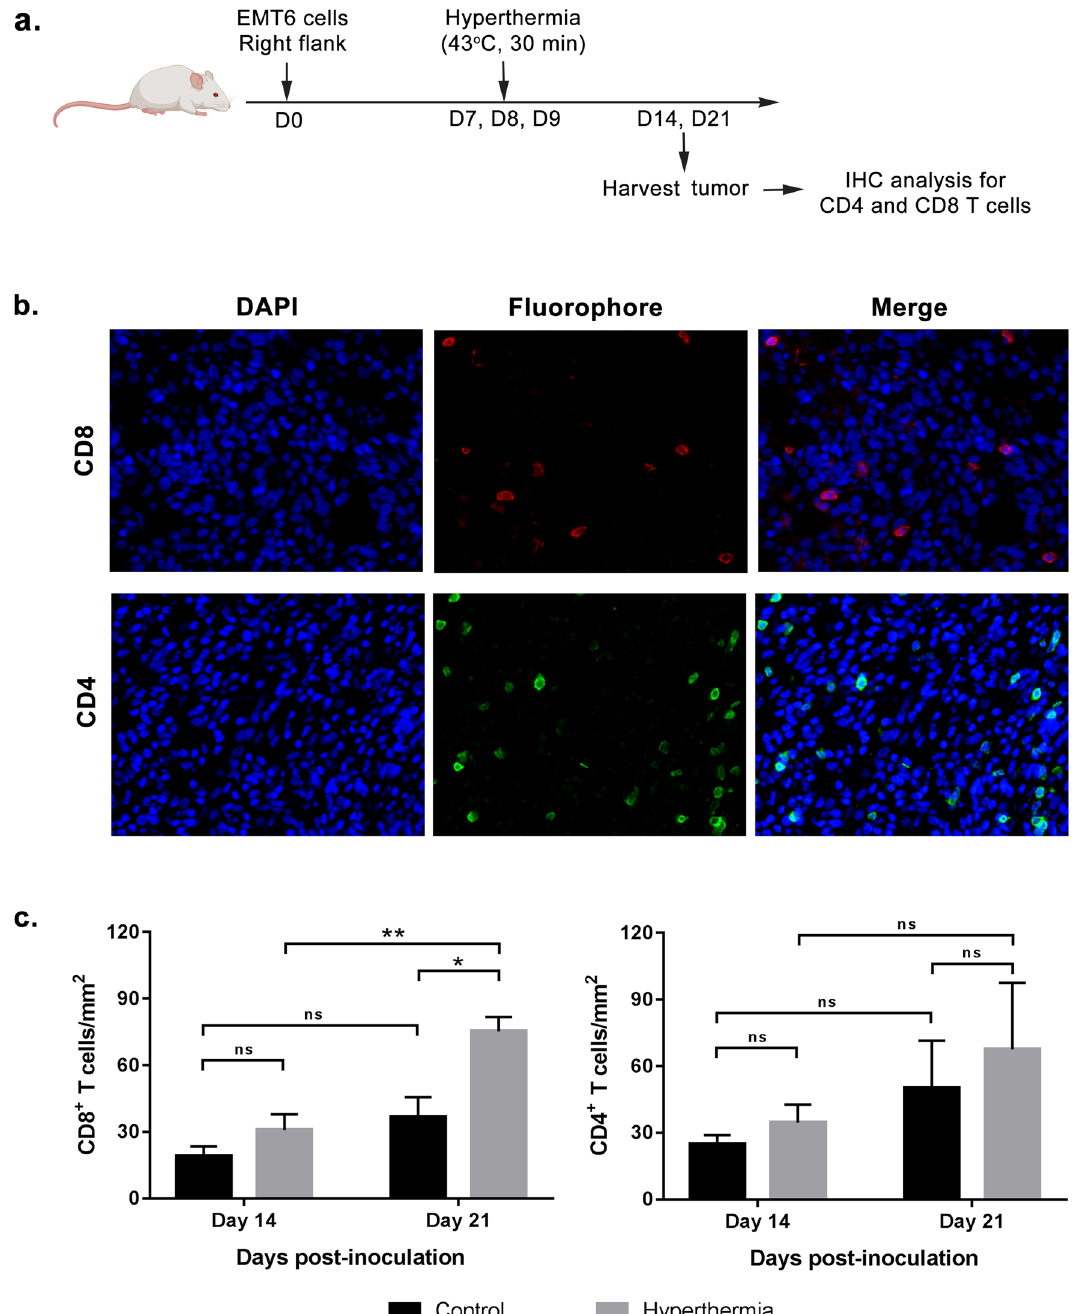
Figure 5. CD8 and CD4 T cells infiltrated in tumor increases over time. Mice were sacrificed at two time points after the treatment; day 14 and day 21 post-inoculation. Tumor were harvested and paraffin-fixed for staining with anti-CD4 and ant-CD8 antibody. ( a ) Schematic time course to measure the number of tumor–infiltrated CD4 + and CD8 + cells by immunohistochemical analysis. ( b ) Representative fluorescence images of stained tumor. ( c ) CD4 + T and CD8 + cell numbers are shown as the median of cells per mm 2 . Each point represents an individual mouse. n = 3–6 per group. ns- P > 0.05, * P < 0.05, ** P < 0.005